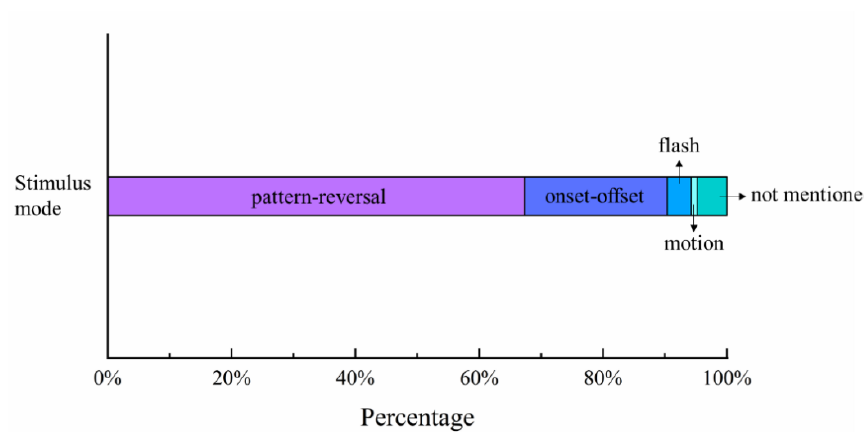
Figure 5. Percentages of stimulus modes used in studies of VEP acuity assessment.